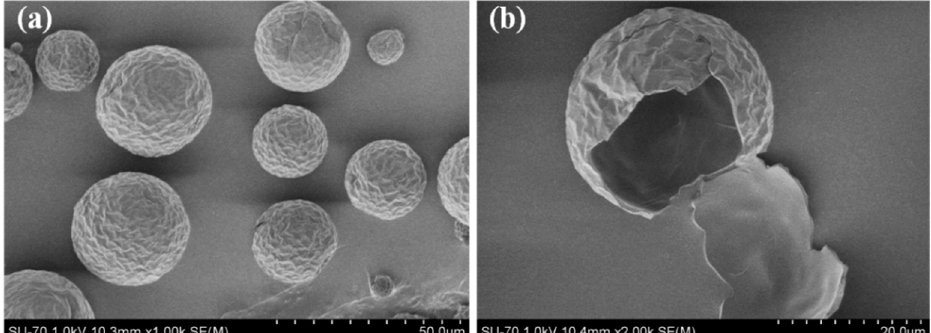
Figure 2. SEM images of ( a ) MicroPCMs, ( b ) the fracture surface of a MicroPCM.